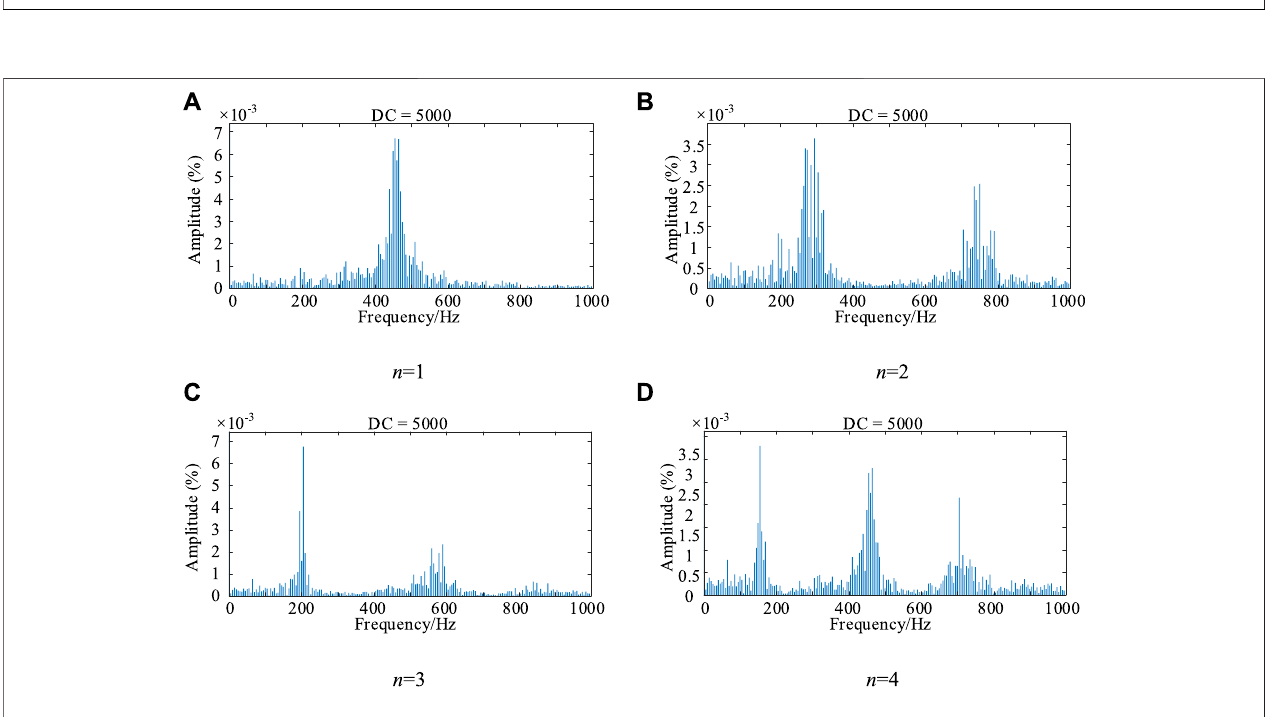
FIGURE 7 | FFT result of the input voltage for load zone 1 (A) n =1 (B) n =2 (C) n =3 (D) n =4.